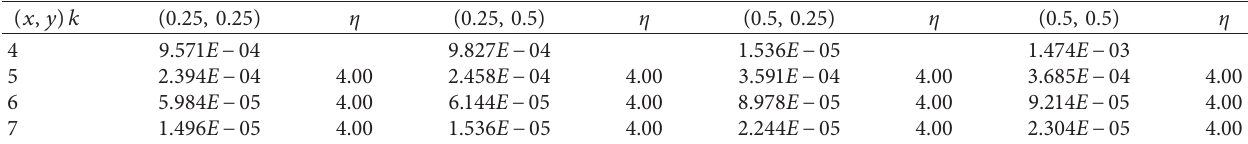
Table 4: The errors for finite difference solutions in the pointwise sense.